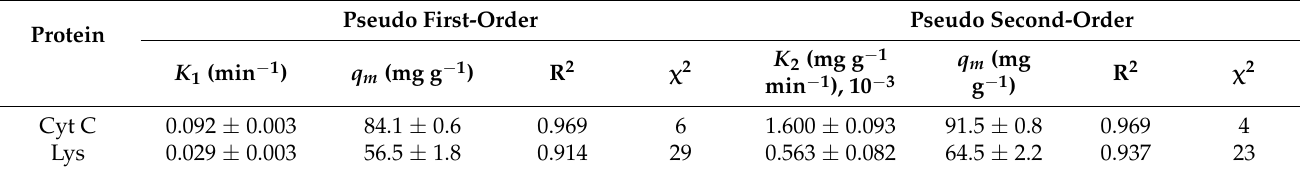
Table 3. Adsorption kinetics